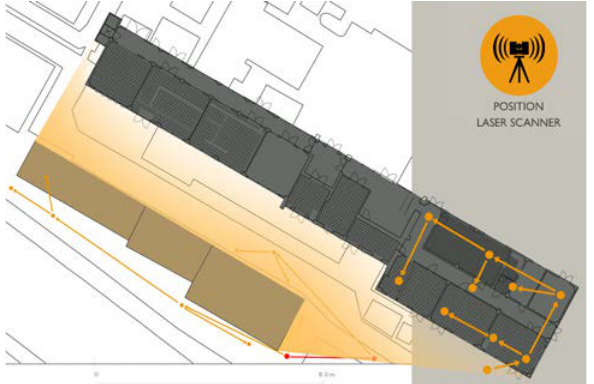
Figure 9: External survey project (building B). The first operation is to build the Revit model from the existing drawings (Figure 10, Figure 11).